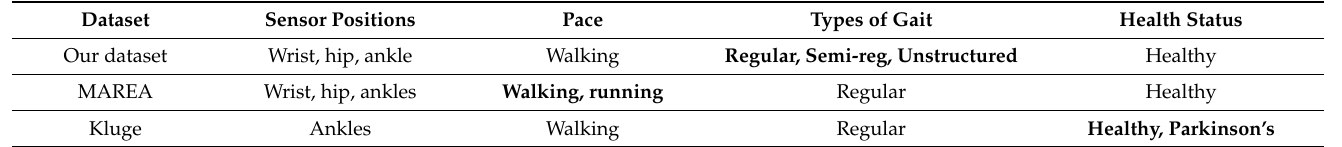
Table 3. Summary of criteria varied in each